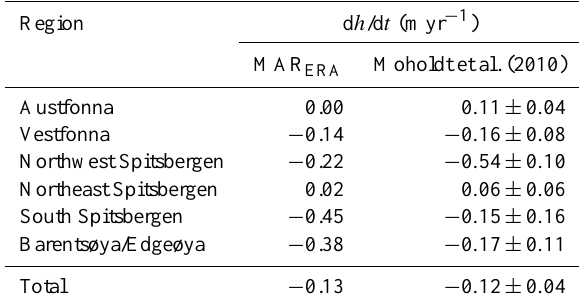
Table 7. 2003–2008 mean elevation changes (d h /d t ,myr − 1 ) from MAR ERA and Moholdt et al. (2010) for different